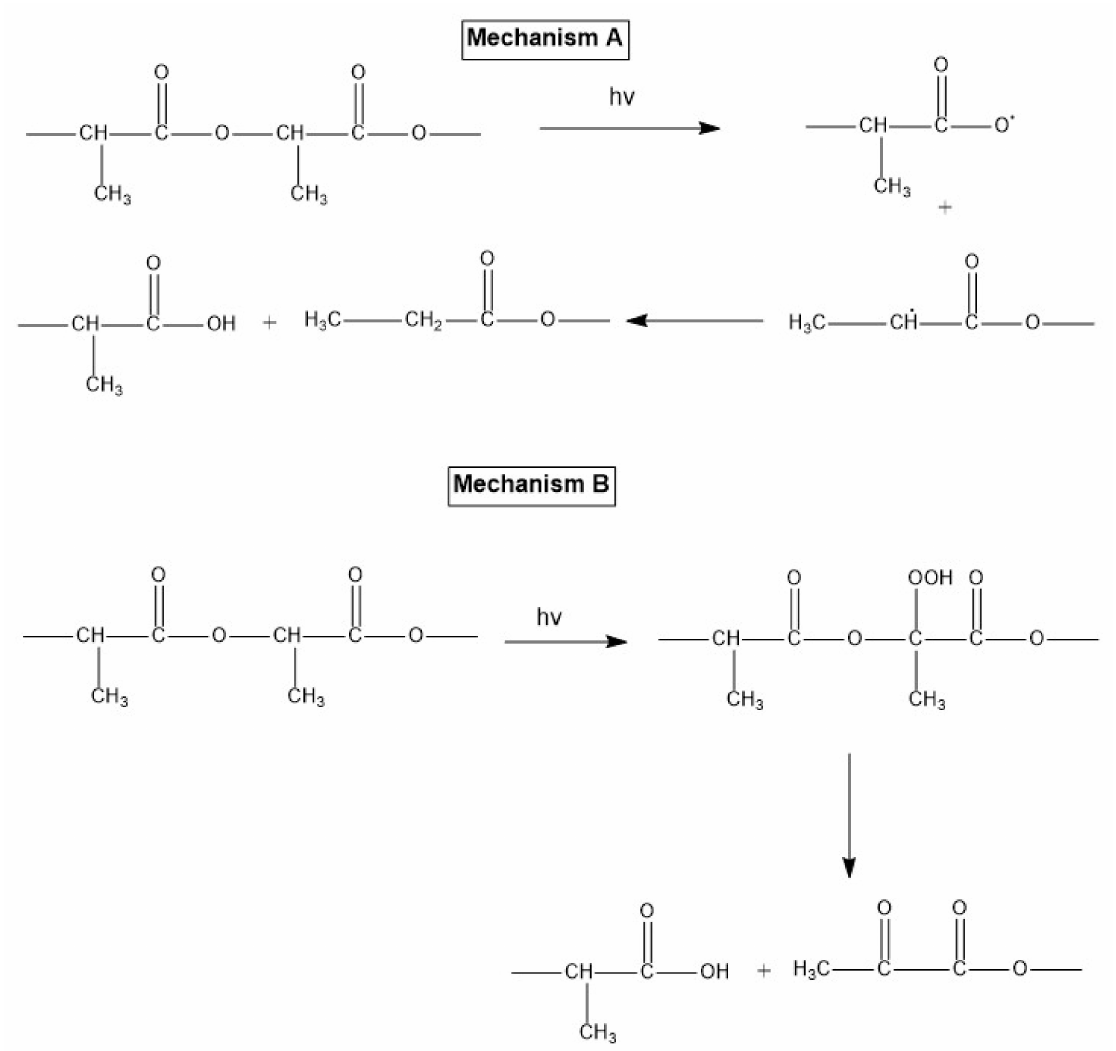
Figure 11. Basic mechanisms proposed to predict the degradation products of PLA adapted from